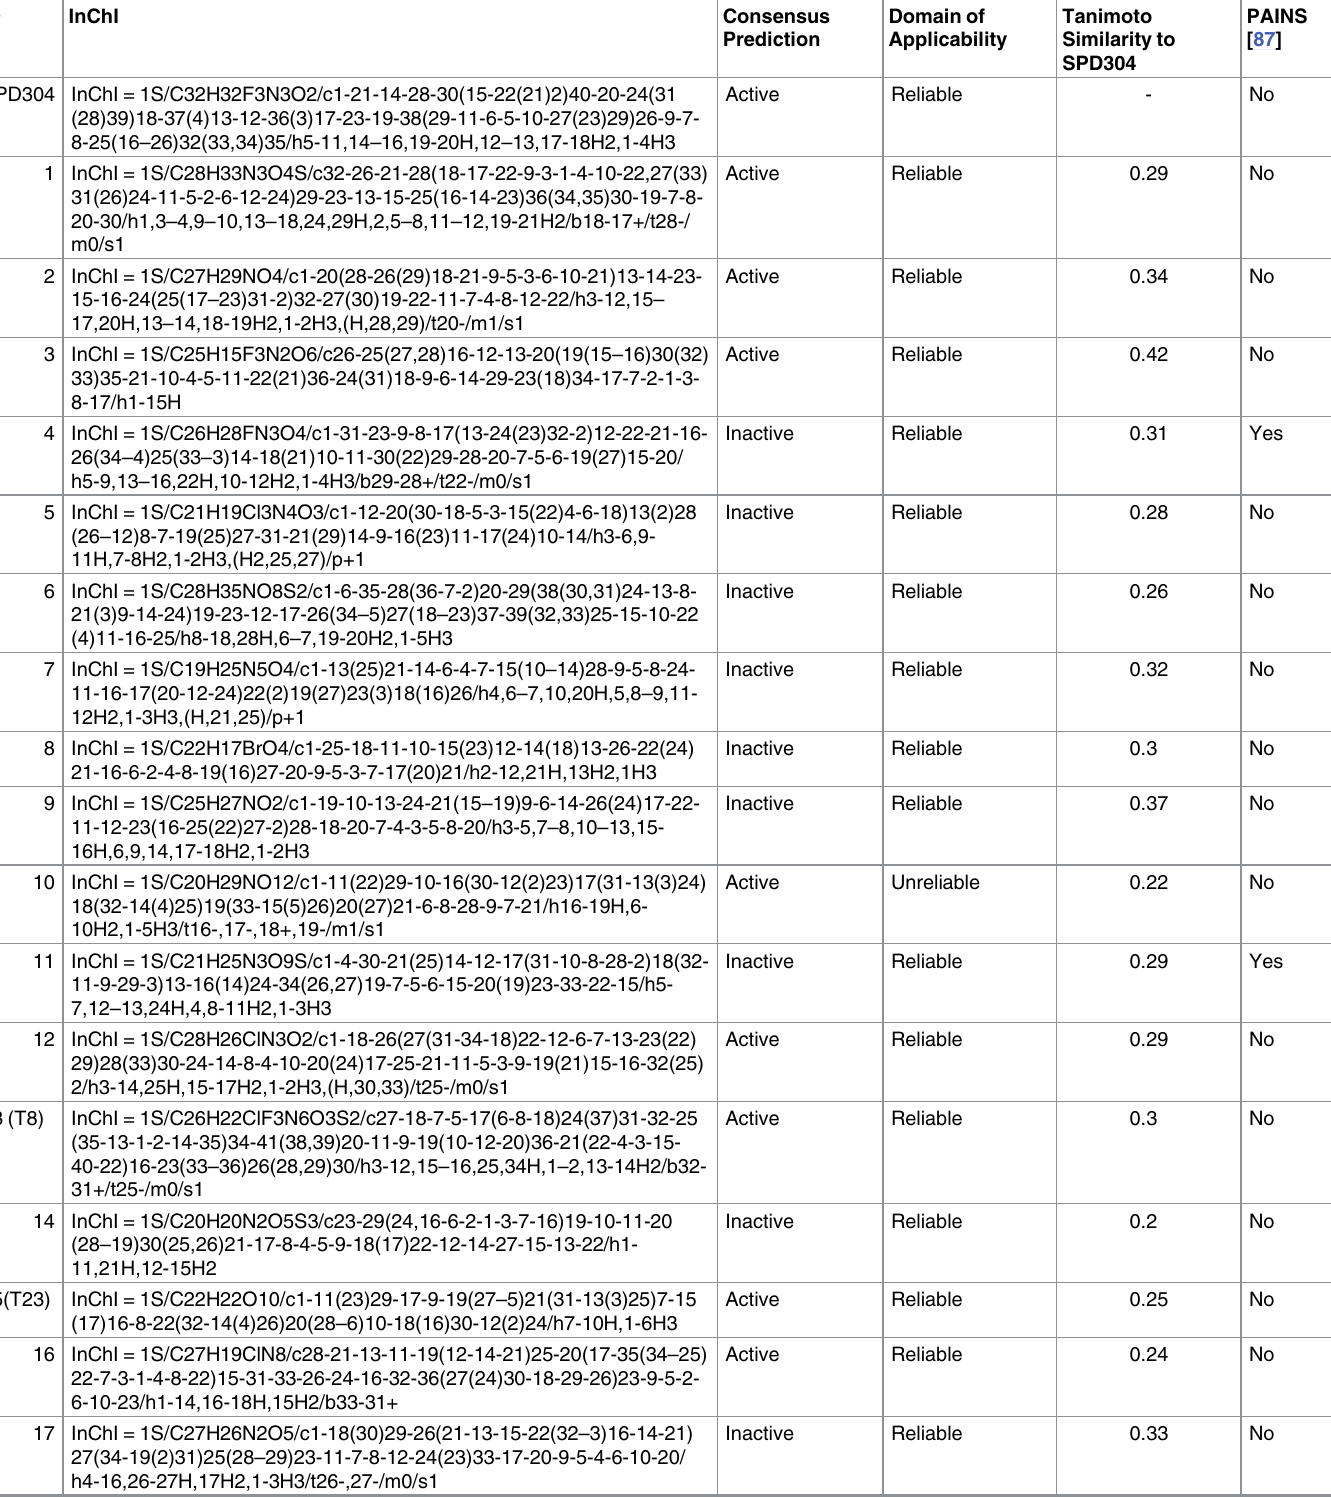
Table 1. Ligand–based predictions through the Enalos cloud platform (http://enalos.insilicotox.com/TNFPubChem/), Tanimoto similarity to SPD304, PAINS check. ID